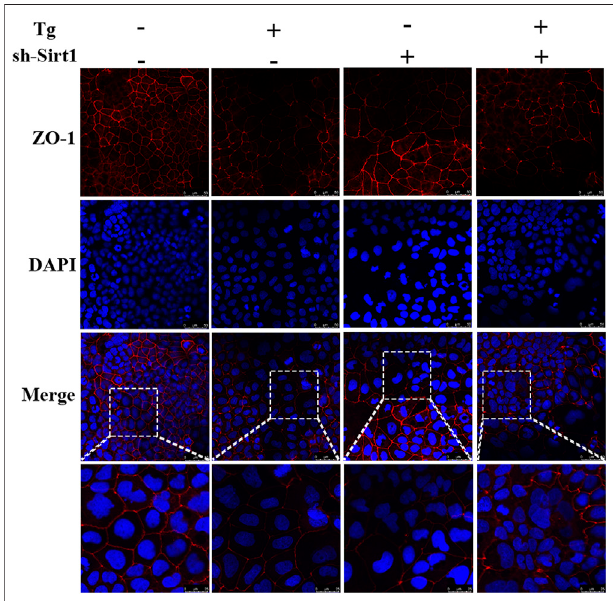
FIGURE 5 | Effects of sh-SIRT1 on ZO-1 levels based on immuno fl uorescence stainingofTg-induced Caco-2 and IEC-6 cells. Dataare presented as the mean ± SEM ( n = 3). Statistically signi fi cant differences are indicated; * p < 0.05, ** p < 0.01, *** p < 0.001, signi fi cantly different from control group. # p < 0.05, signi fi cantly different from Tg group.